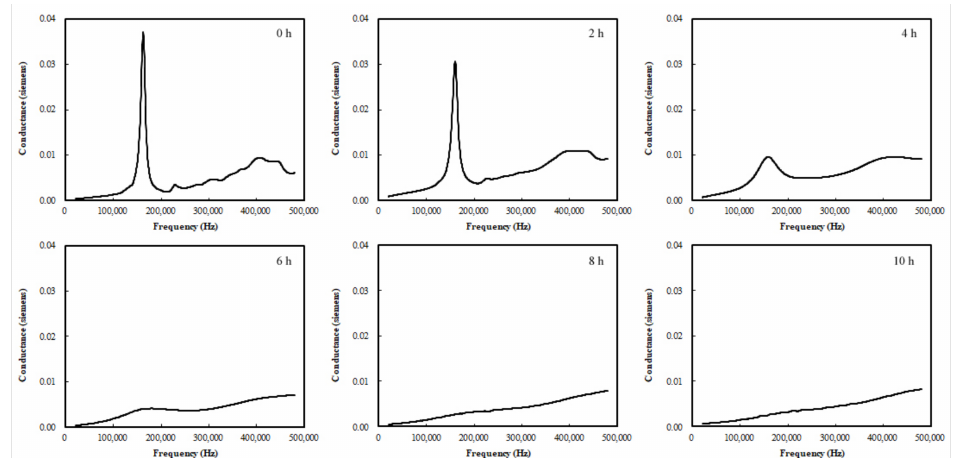
Figure 5. Conductance (real component of admittance) of PZT patch in cement paste at different material